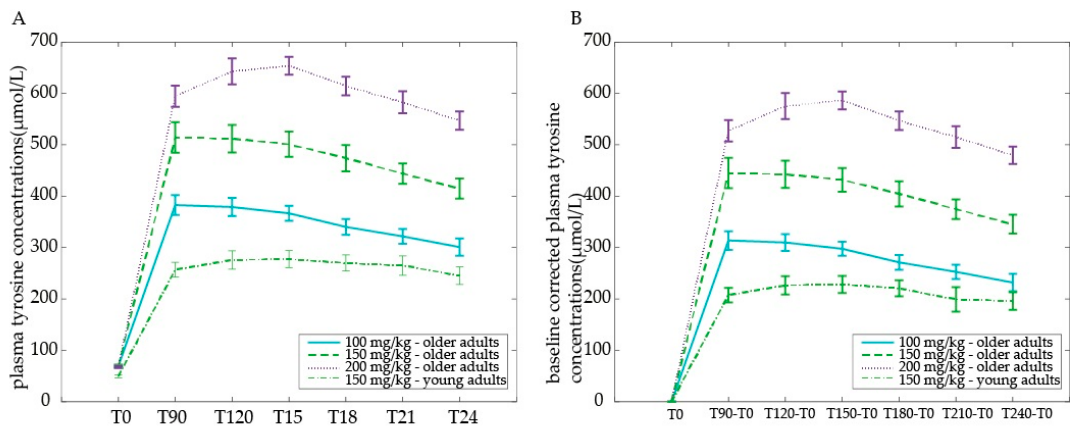
Figure 4. Plasma tyrosine concentrations after tyrosine administration, by tyrosine dose and age group.